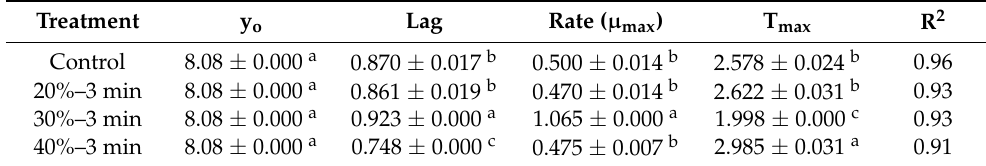
Table 4. Effect of ultrasound amplitude on the kinetic growth parameters of Lactobacillus acidophilus (media ± standard deviation).